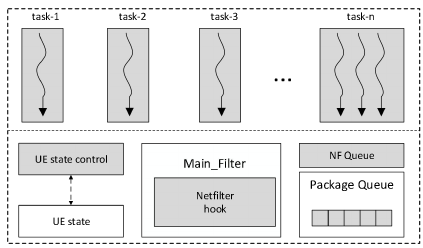
Fig. 3. (a) The jitter of Wi-Fi signal when the smartphone was near to the AP